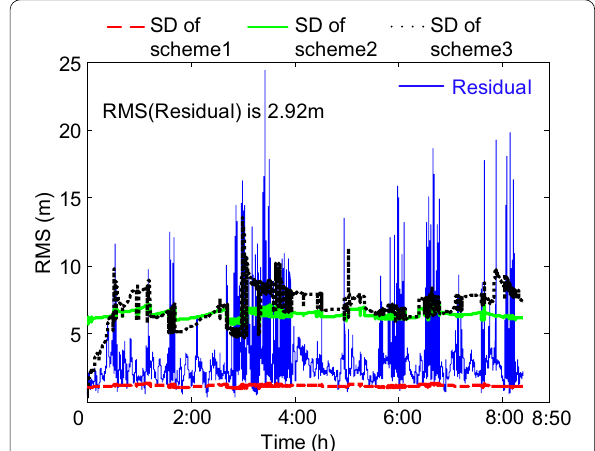
Fig. 5 RMS of pseudorange measurement residuals and standard deviation